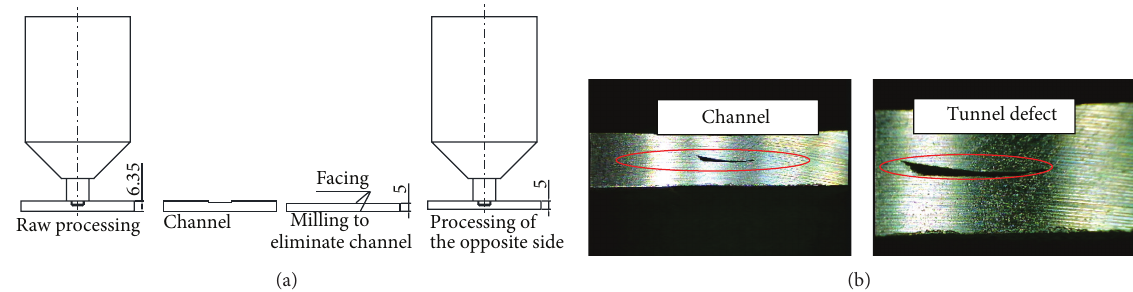
Figure 6: (a) Friction Stir Processing steps units (mm). (b) Tunnel defect after processing the opposite side.